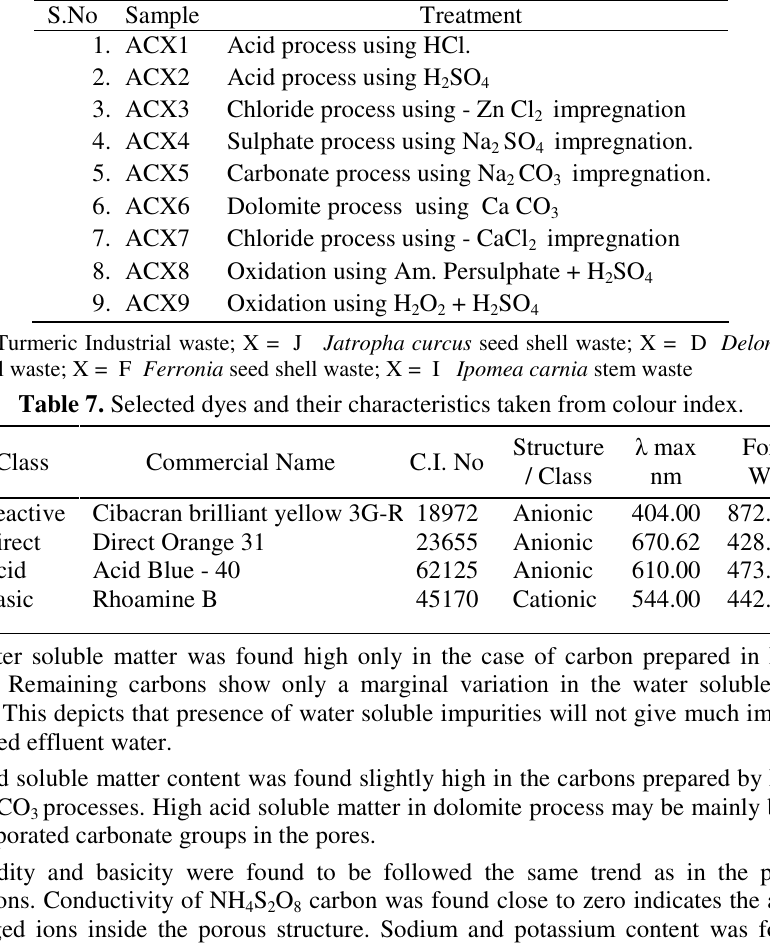
Table 6 . List of various activation process and abbreviation of carbon